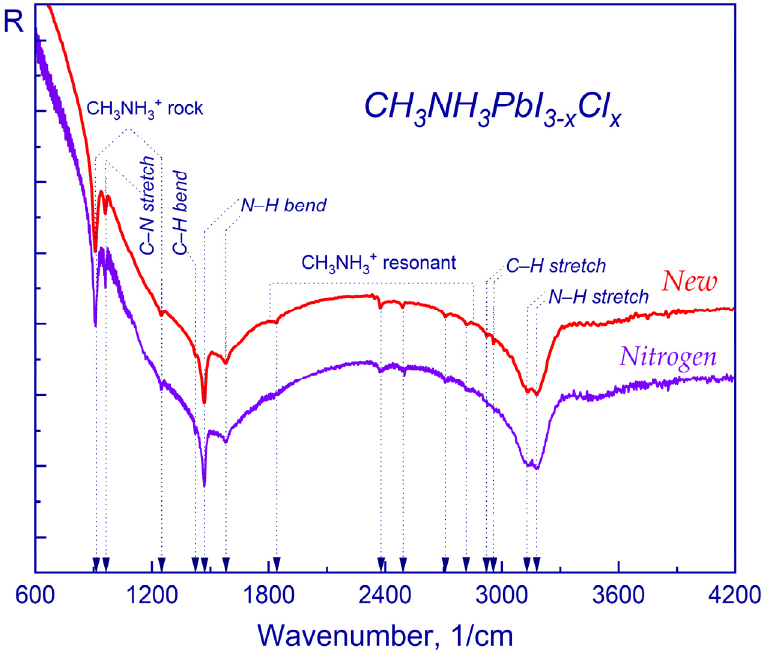
Figure 3. Fourier transform IR spectra of CH 3 NH 3 PbI 3-x Cl x : freshly prepared (red) and exposed to nitrogen (purple).